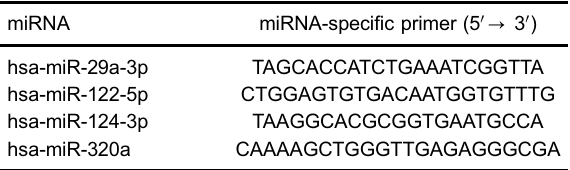
Table 1. MicroRNA-speci fi c primer sequences